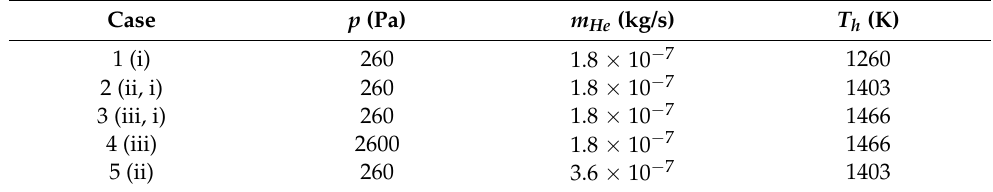
Table 1. DOE of the five operative conditions for the PBM and MoM, where p is pressure (Pa), m He is mass flow rate (kg/s), and T h is temperature (K). The Roman numerals between round brackets represent the subclass identifier for each of the three operative conditions (i: varying T h ; ii: varying m He , and iii: varying p ). The collection surface was cooled by liquid nitrogen in all cases. Case 𝒑 (Pa) 𝒎 𝑯𝒆 (kg/s) 𝑻 𝒉 (K)